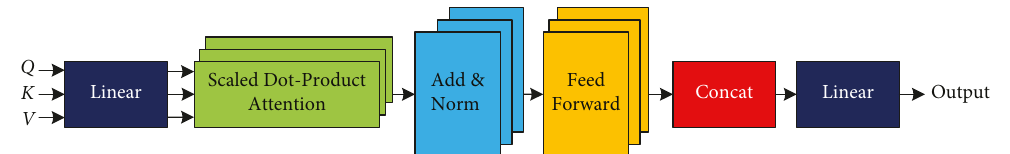
Figure 1: The architecture of the transformer-based model, where Q , K , V are three matrices representing queries, keys, and values, respectively.